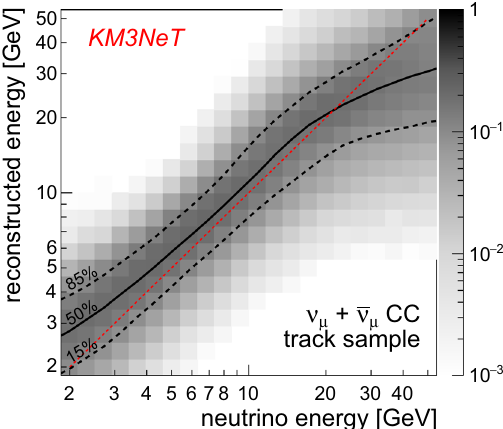
Fig. 2 Probabilitydistributionofthereconstructedenergyasafunction of true neutrino energy for upgoing ν e CC and ν e CC events classified as shower-like (left) as well as ν μ CC and ν μ CC events classified as